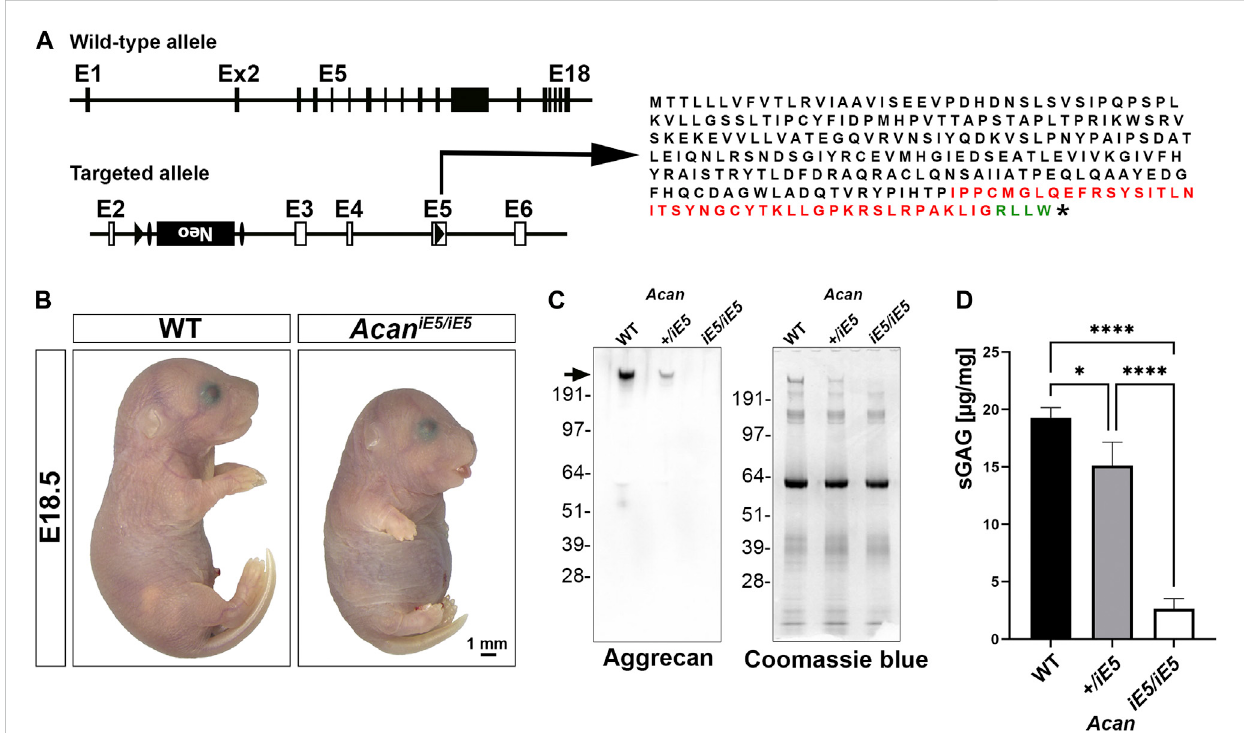
FIGURE 1 Generation of Acan -de fi cient mouse. (A) Targeted inactivation of the Acan gene. The Acan locus was targeted by introducing a lox P site into exon 5 and a lox P- Frt - neo - Frt cassette into intron 2. Insertion of lox P in exon 5 resulted in the translation into a 263 aa long truncated protein. Black, red and green colors represent amino acids of aggrecan, insertion sequence and non-aggrecan, respectively, before the stop codon (*). (B) Representative macrophotograph of WT and Acan iE5/iE5 E18.5 embryos. Homozygous mutant mice die shortly after birth due to respiratory distress and exhibit abnormal phenotype characterized by severe skeletal malformations. (C) Western blot (left) against the full form of ACAN (arrow) demonstrates the complete absence of protein in the pooled cartilage tissue of the developing knee at E18.5 in Acan iE5/iE5 mice, and about 50% reduction in Acan +/iE5 mice. On the right, Coomassie blue staining shows equal protein loading of the gel. (D) 1, 9-dimethylmethylene blue assay showing the partial and almost complete loss of sGAG in respectively, Acan +/iE5 and Acan iE5/iE5 E18.5 embryos cartilage tissue ( n = 3). Statistical signi fi cance calculated by one-way ANOVA with Tukey ’ s multiple comparison test, where *: p ≤ 0.05 and ****: p <